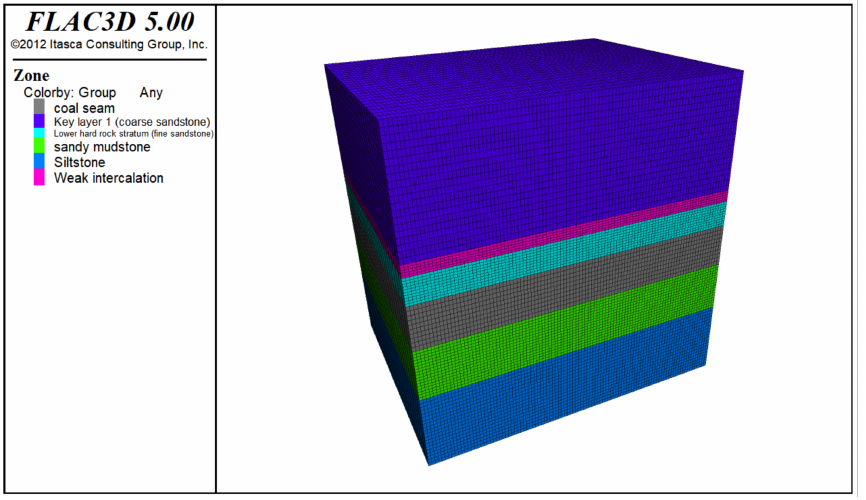
Figure 6. Numerical